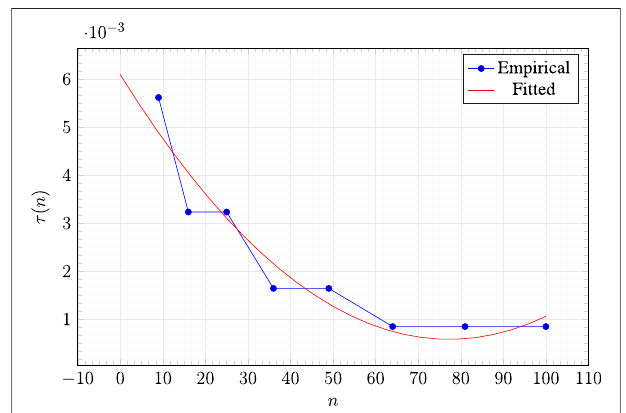
FIGURE 3 | Experimental values for the optimal threshold τ ( n ) (see text) and corresponding fi tted model.